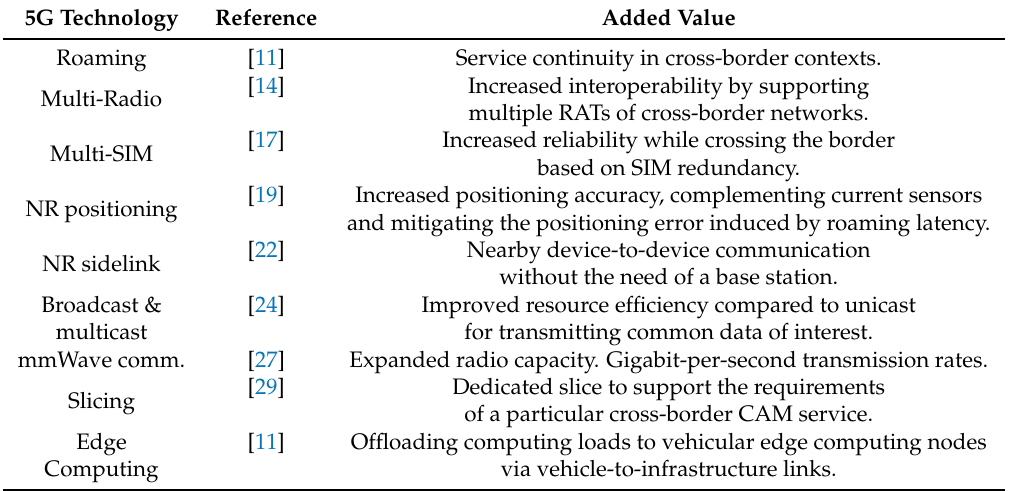
Table 1. Added value brought by 5G technologies to cross-border connected automated mobility (CAM)